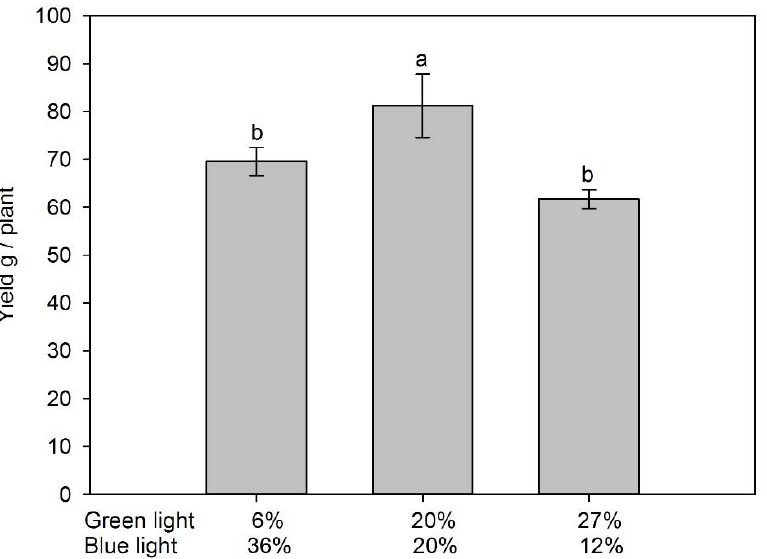
Figure 3. Effect of the green (500–600 nm) and blue (400–500 nm) light balance on fruit yield of strawberry plants grown in an indoor vertical system with LED lighting. Bars represent the standard error of the mean. Bars represent the standard error of the mean. Columns with different letters indicate significant differences according to Duncan´s multiple comparison test with p < 0.05. Table 2. Effect of the green (500–600 nm) and blue (400–500 nm) light balance on the number of leaves and crowns and on the fresh mass of plant parts of strawberry grown in an indoor vertical system with LED lighting.